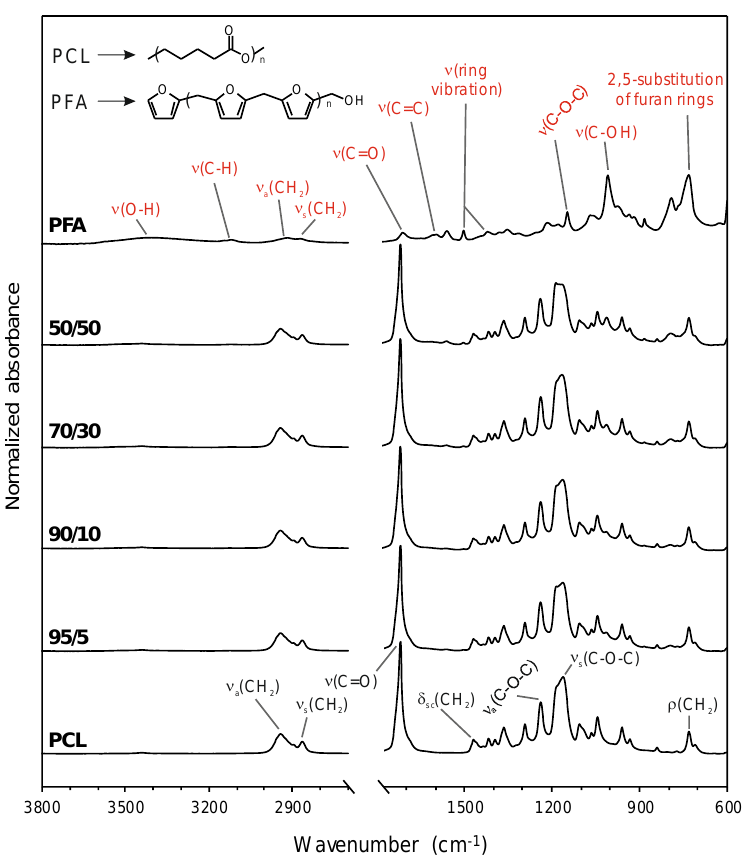
Figure 2. Attenuated total reflection-Fourier transform infrared (ATR-FTIR) spectra of pure PCL and PFA resin as well as blend films. The band assignments of PCL (black) and PFA (red) as well as the chemical structures of both substances are included.